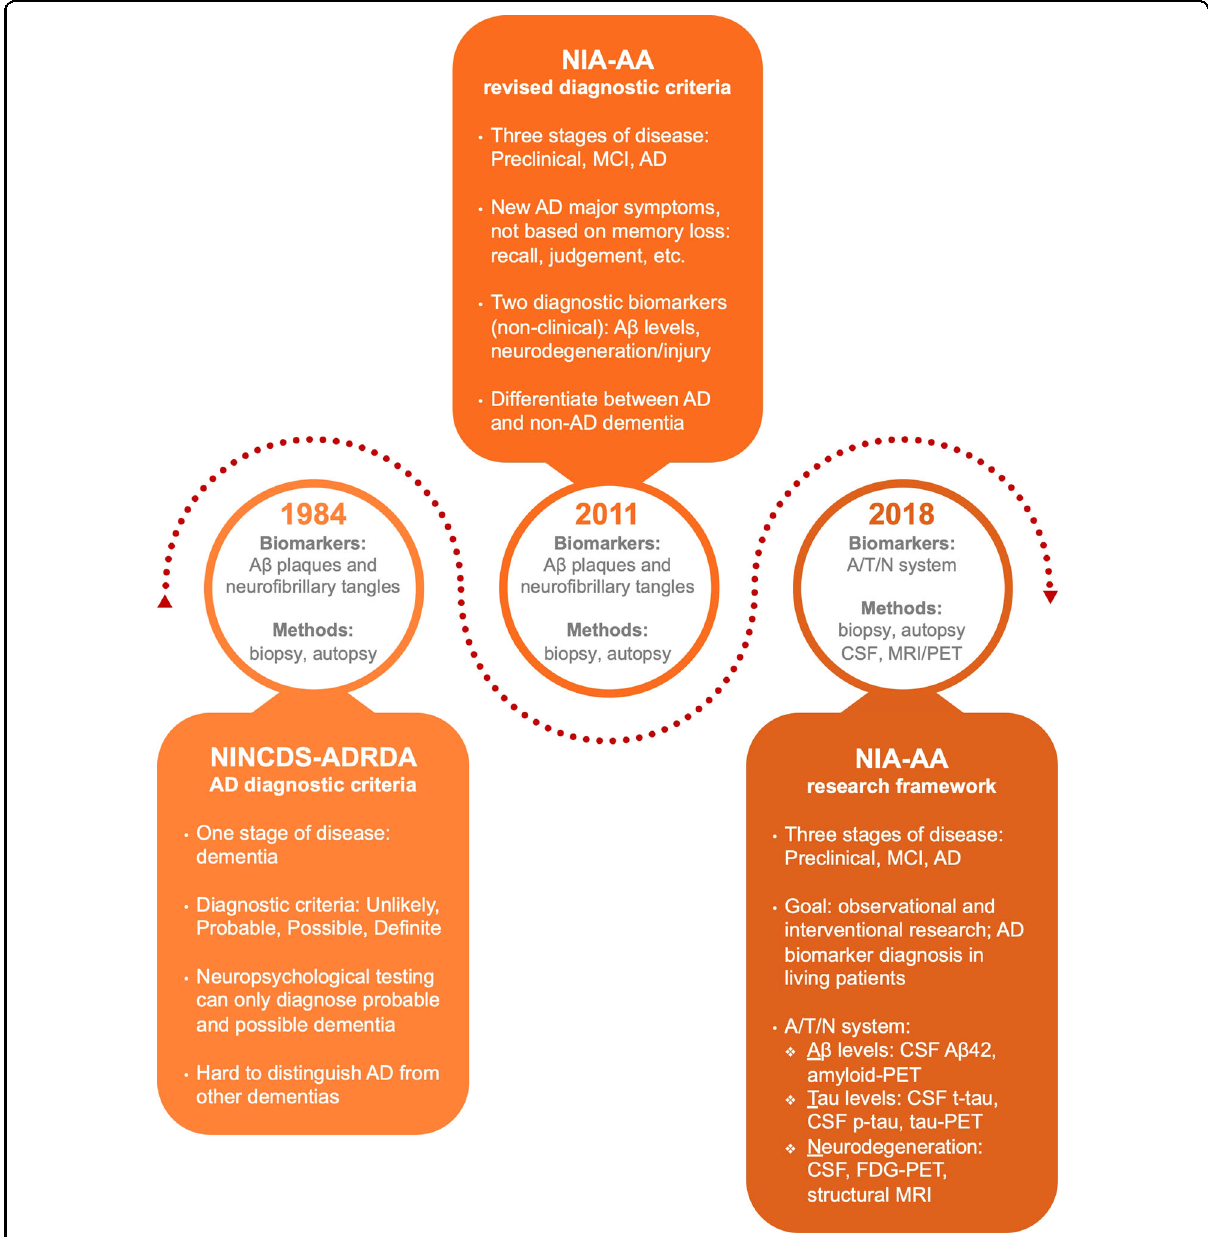
Fig. 1 Evolution of AD diagnostic criteria. A timeline of revisions applied to the protocols for AD diagnosis. As the understanding of AD pathology has developed, the criteria for diagnosis have re fl ected this expansion of knowledge. The clinical diagnostic standard underwent two major revisions after its initial publication in 1984, with the latest revision occurring in